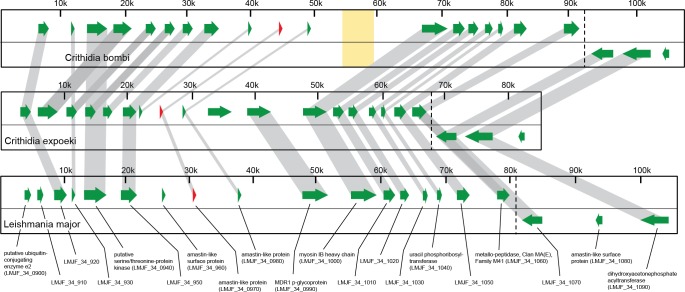
Genome organisation.Here we show sections of the genomes (kilobases, kb) of C. bombi and C. expoeki (top two panels; (scaffold3_4 and scf7180000000921, respectively) and the syntenic region in L. major (bottom panel) as an example of overall synteny among these genomes. Green arrows are gene sequences coding for proteins, as based on annotations in L. major and as indicated at the bottom. Reversed (left-facing) arrows indicate polycistronic regions. Note that, in this example, no introns are present. The red arrow refers to the amastin-like protein (LmjF.34.0970 in L. major), which is an ortholog to gene Ce.1.39770 (C. expoeki) and Cb.1.06720 (C. bombi). Two further amastin-like proteins are immediately up- and downstream from this location. The grey bars connect orthologs within the same orthologous group, as based on the OA analysis, and demonstrate a high degree of synteny among the three species. The yellow zone represents a gap in the C. bombi scaffold.